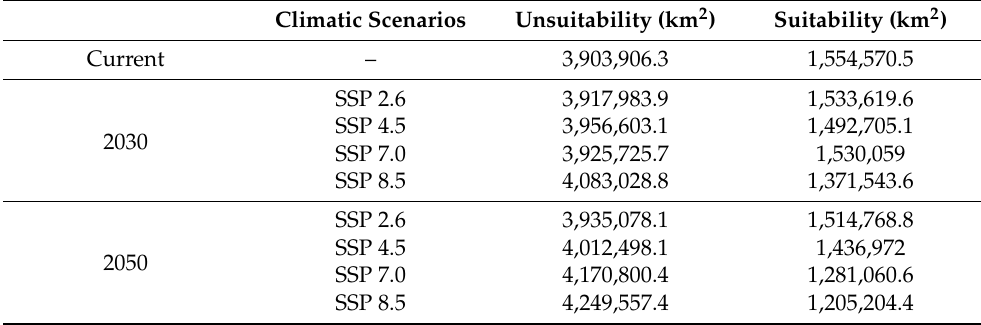
Table 6. Predicted suitable areas under the current and future climatic conditions during June– September (India).